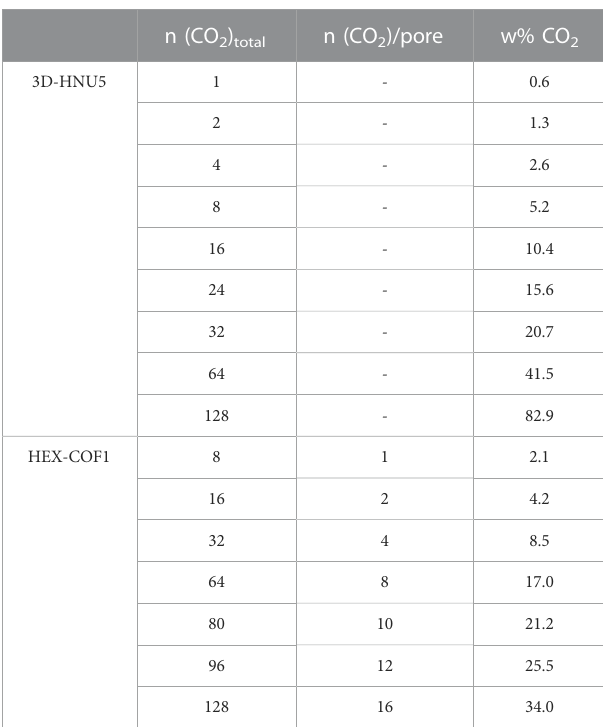
TABLE 2 Simulated compositions of the gas@host systems considered in case of 3D-HNU5 and HEX-COF1.